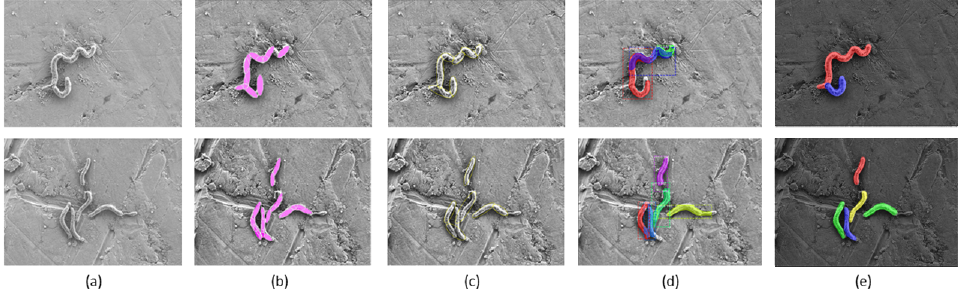
Figure 7. The segmentation results for two instances of ( a ) original SEM images, column ( b ) shows Zou et al. [13] ellipse fitting segmentation, column ( c ) shows Abeyrathna et al. [49] ellipse fitting segmentation, column ( d ) shows mask R-CNN instance segmentation, and column ( e ) shows segmentation through the current